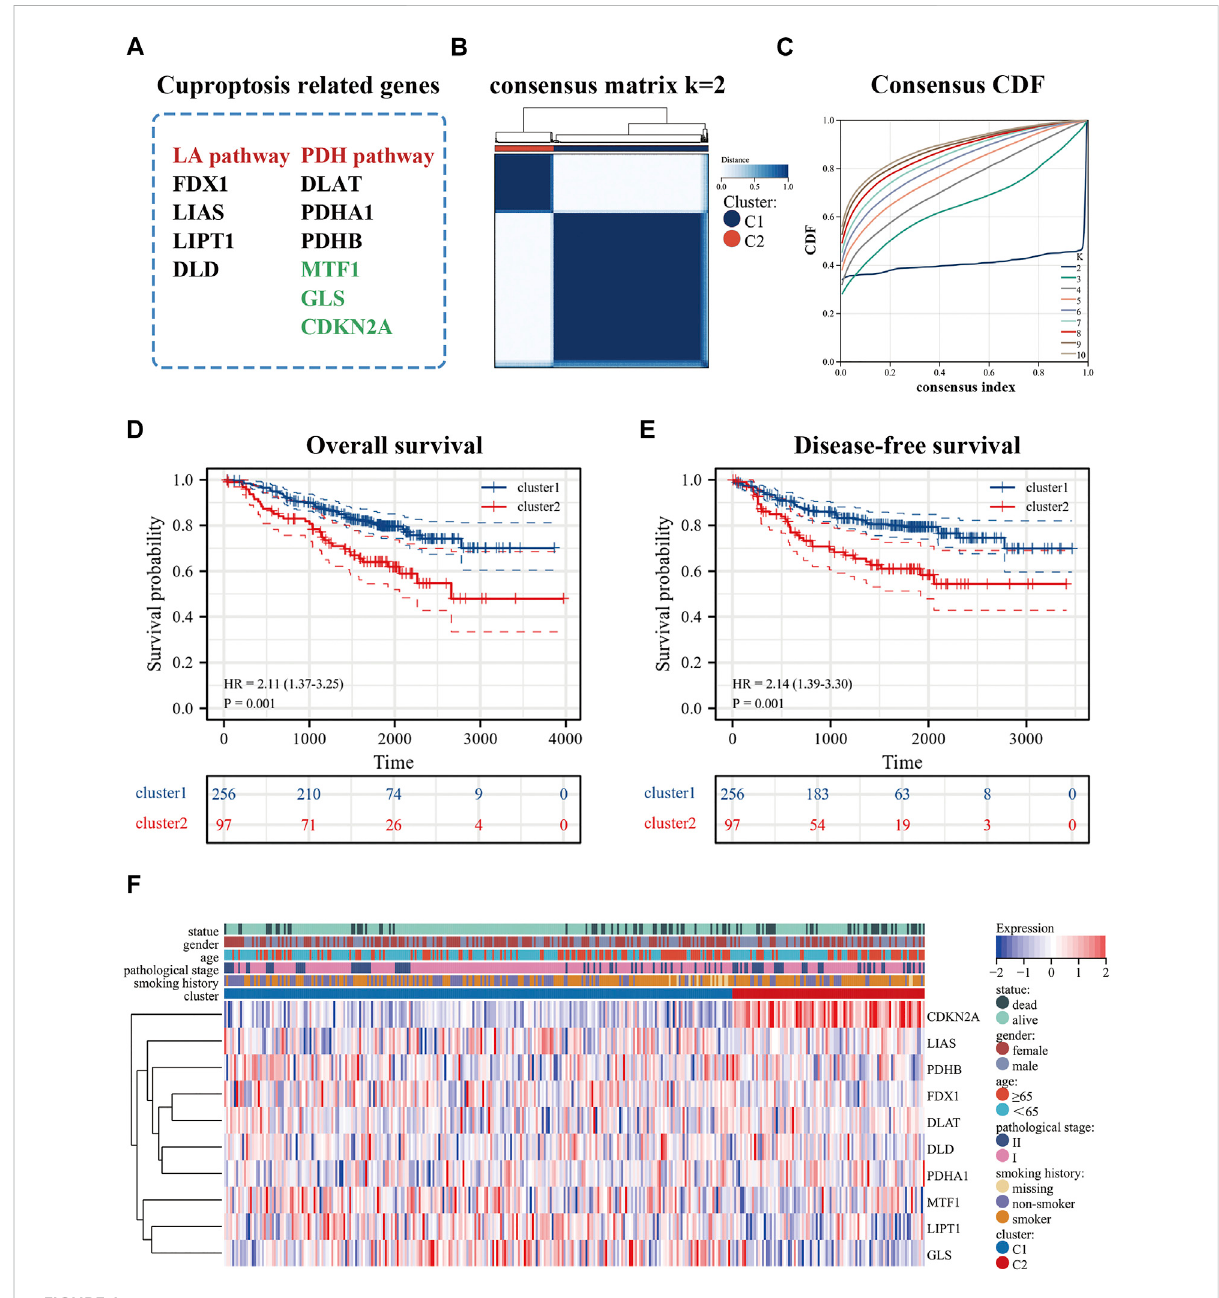
FIGURE 1 Identi fi cation of cuproptosis-related patterns. (A) cuproptosis-related genes; (B,C) Consensus clustering analysis by the cuproptosis-related genes (k = 2); (D,E) KM analysis was used to plots OS and DFS curves of es-LUAD patitents (blue represented cluster1 pattern while red represented cluster2 pattern); (F) The heat map showed the expression and clinicopathological characteristics of the cuproptosis-related genes in two clusters. KM: Kaplan-Meier; OS: Overall survival; DFS: Disease-free survival; es-LUAD: early-stage lung